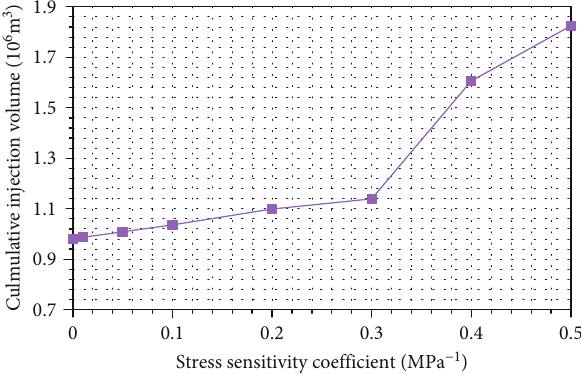
Figure 10: The cumulative injection volume of CO with di ff erent stress sensitivity coe ffi